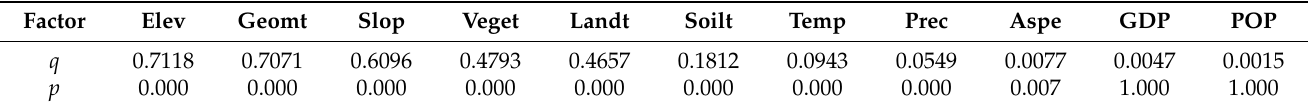
Table 4. Detection of the significant driving factors for the spatial differentiation of CI.